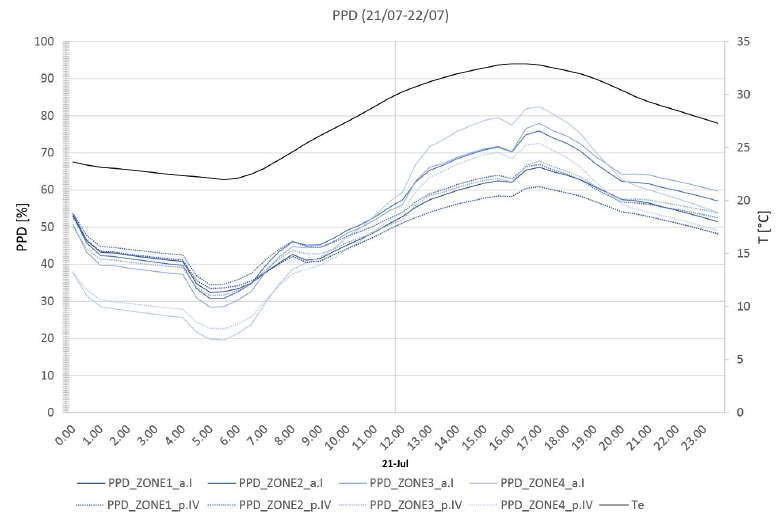
Figure 17. Comparison between PPD in current and low-e configuration of different floors during a typical summer week.